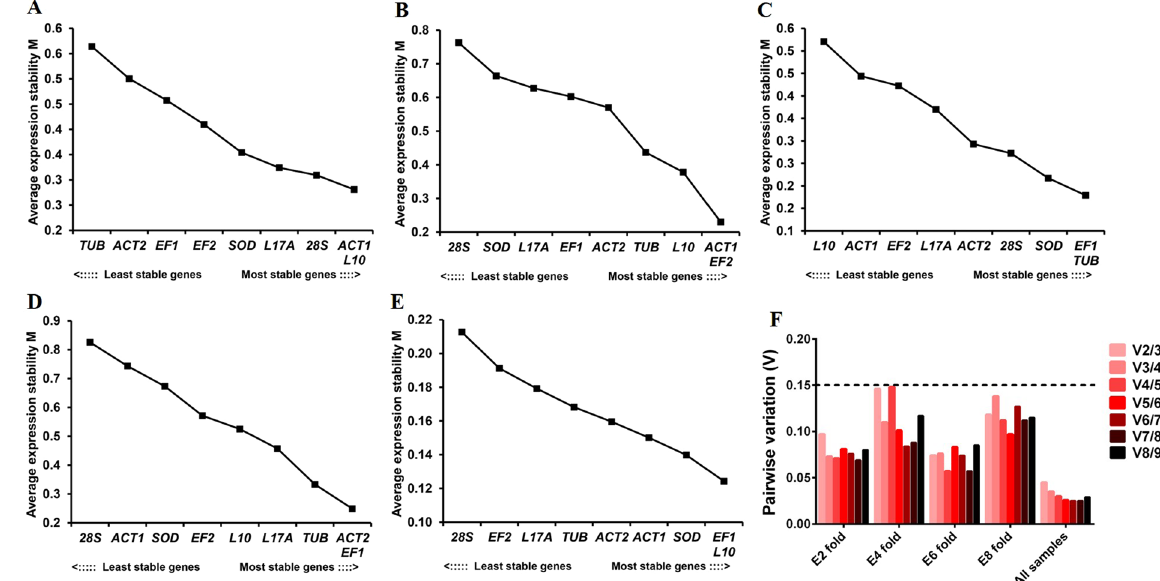
Figure 4. Validation of 9 candidate reference genes with these samples under different concentrations of ascoviruses in the IOZCAS-Spex-II-A cell line using geNorm. Virus concentration diluted 100 multiples ( A ), virus concentration diluted 10,000 multiples ( B ), virus concentration diluted 1,000,000 multiples ( C ), virus concentration diluted 100,000,000 multiples ( D ), and all samples set ( E ). ( A , B , C , D , E ) represent average expression stability values (M) of 9 candidate genes, and ( F ) shows determination of the optimal number of candidate genes for normalization by geNorm analysis.